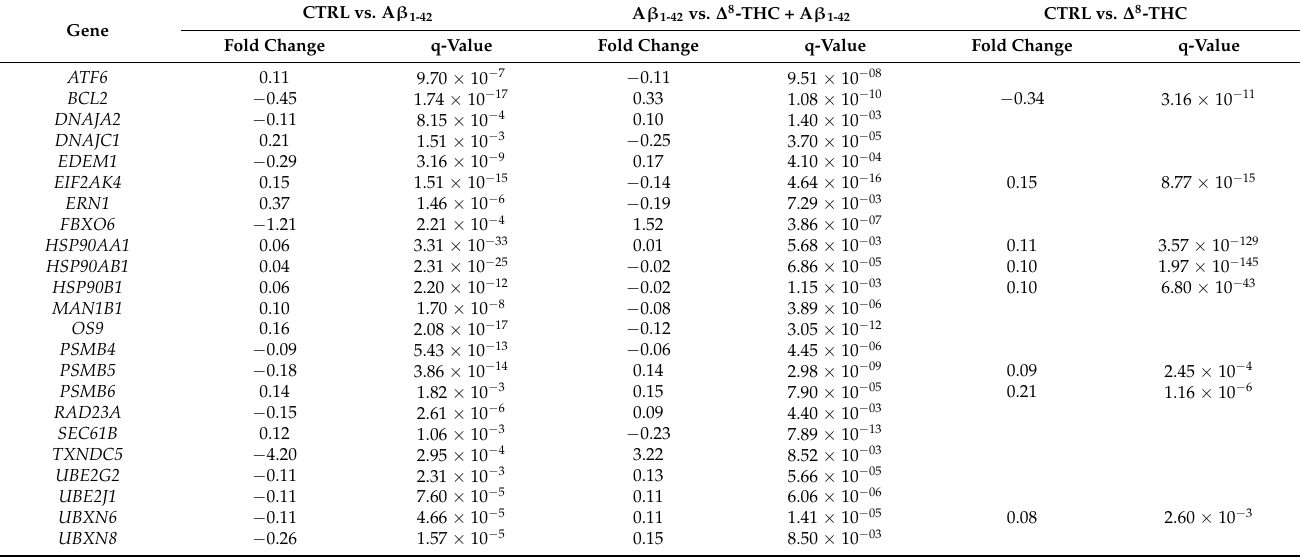
Table 1. Common DEGs, altered in both CTRL vs. Aβ 1-42 and Aβ 1-42 vs. Δ 8 -THC + Aβ 1-42 , related to “Alzheimer’s disease” (hsa05010) and “protein processing in endoplasmic reticulum” (hsa04141) pathways.